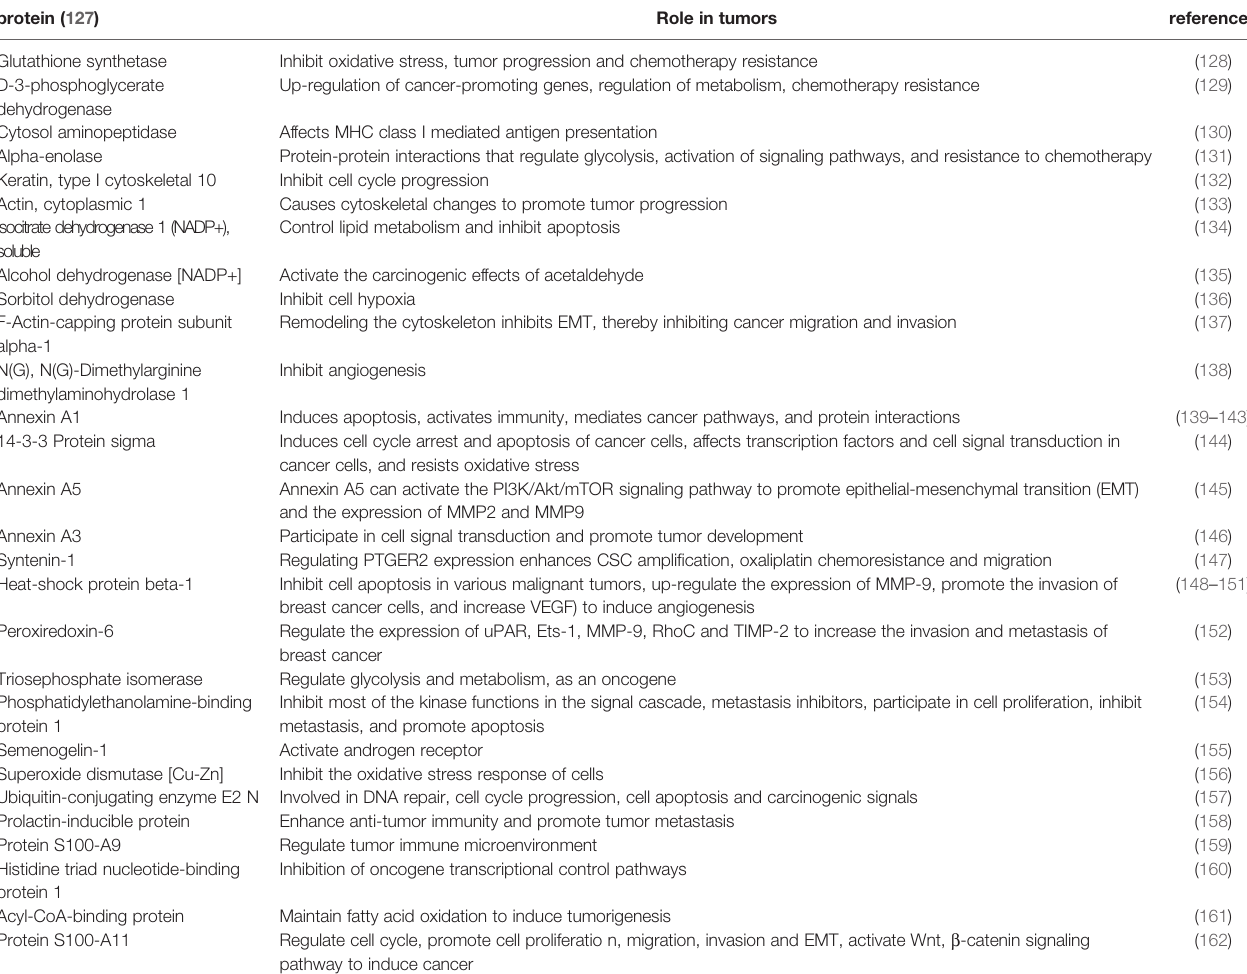
TABLE 4 | Exosomal proteins in prostate cancer